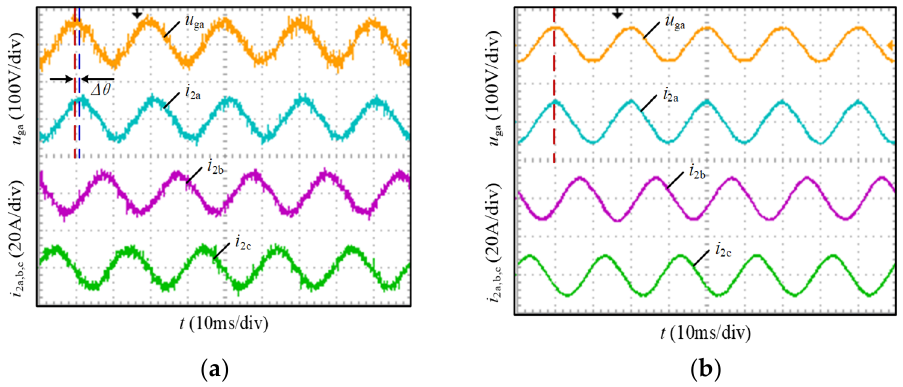
Figure 14. Steady-state experimental results: ( a ) Traditional scheme; ( b ) proposed scheme.